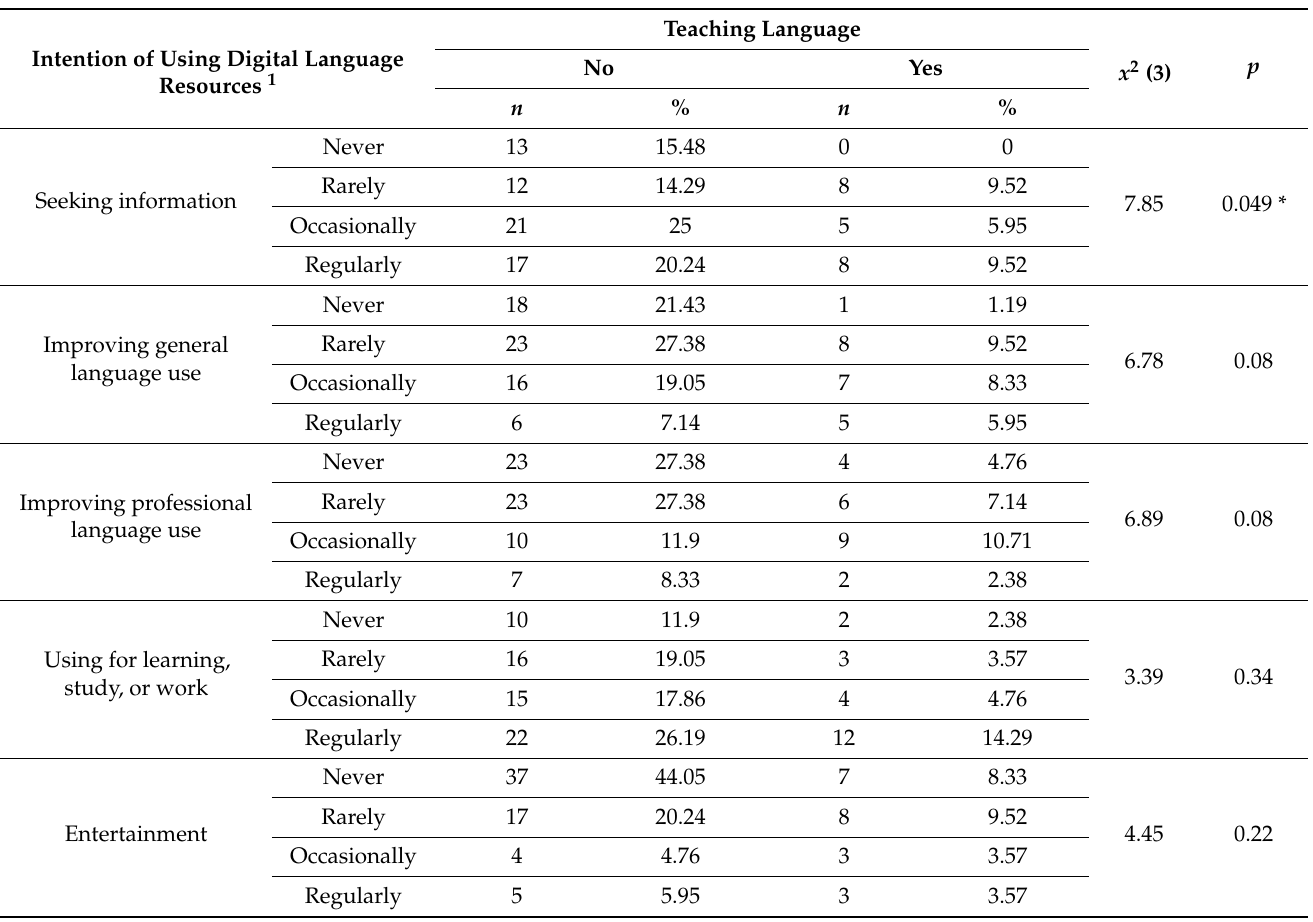
Table 3. Chi-square comparison table of participants, teaching language or not, with various types of